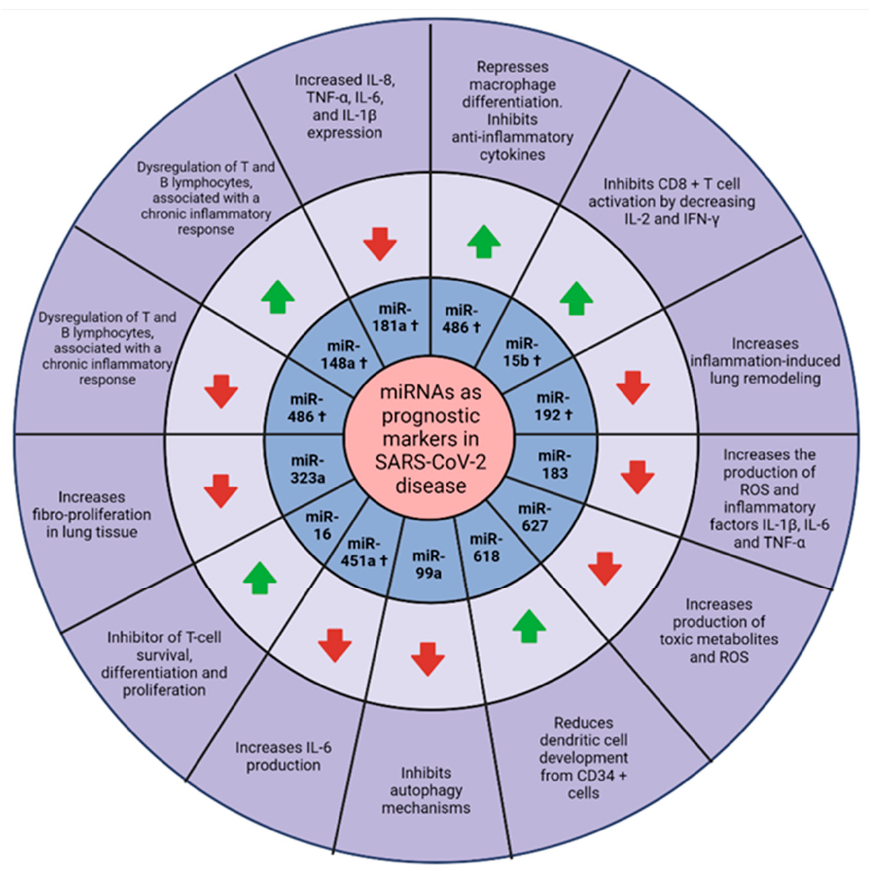
Figure 4. Main miRNAs reported as possible prognostic markers in COVID ‐ 19. † miRNAs specific to severe COVID ‐ 19.